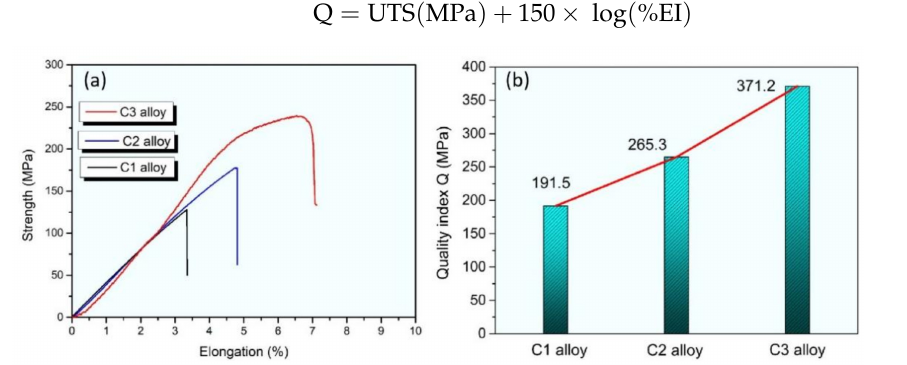
Figure 7. ( a ) Tensile properties of the alloys with different cooling rates. ( b ) The quality index Q of the three